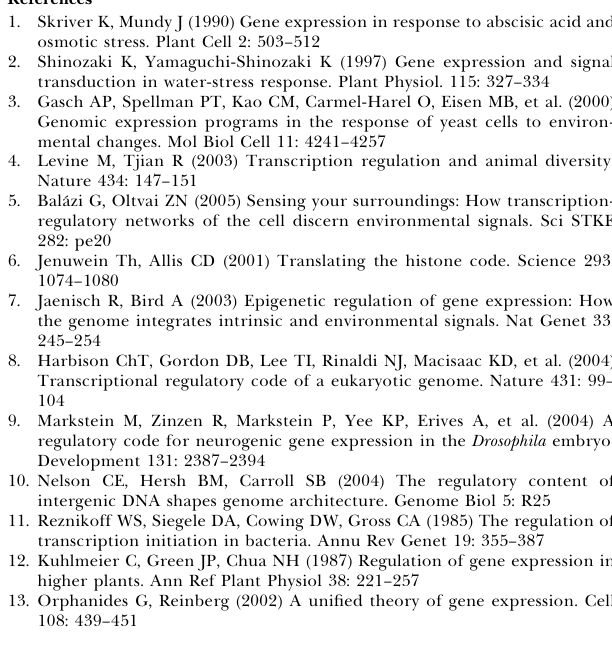
Figure S2. Correlation of the Number of cis -Regulatory Elements in 500-Nucleotide Upstream Promoter Regions of Varying Length with the Breadth of Differential Gene Expression Response